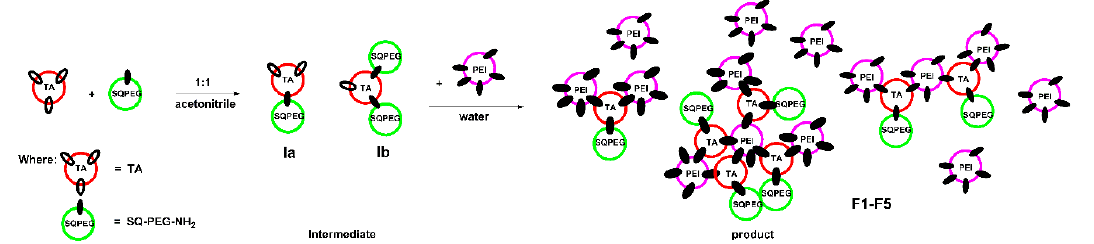
Figure 1. Schematic representation of the two-step synthesis of DCFs F1–F5.